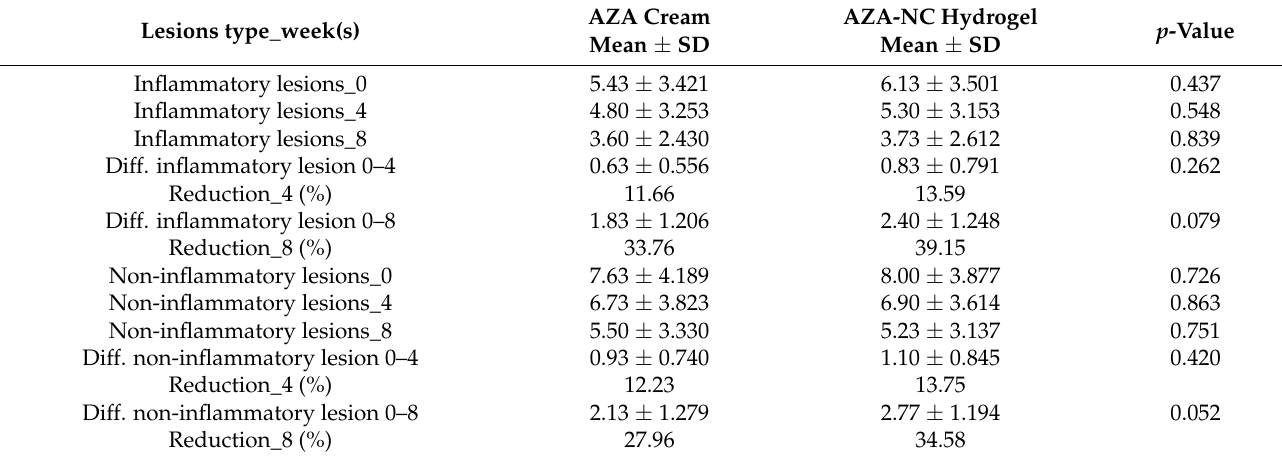
Table 4. The mean number and percentage reduction in inflammatory and non-inflammatory lesions after 4 and 8 weeks of treatment.